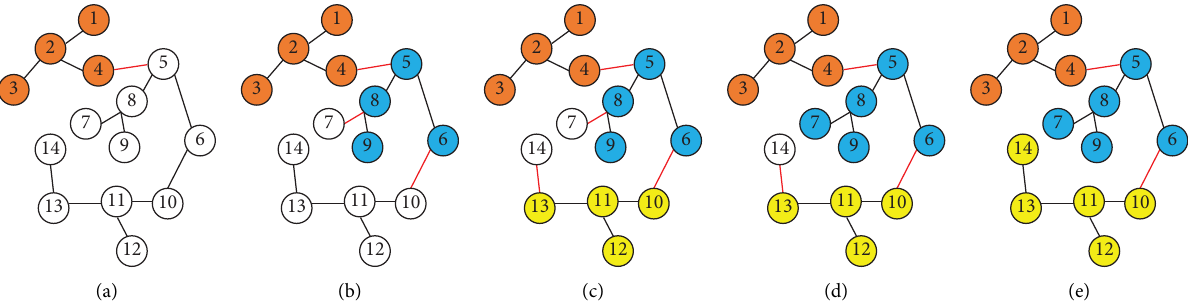
Figure 2: Te initial population generation procedure is explained from left to right. (a) Te edge (4, 2) gets chosen, and its end nodes (the nodes connected to both ends of the edge) get assigned to the corresponding community. Te edges of node 2 get processed, and the �� √ ��� |√ | n ⌉ � 􏼆 􏼇 � 4 ) , stops the expansion of the community, and chooses another edge; (b) procedure reaches the predefned threshold (⌈ 14 the edge (5, 8) gets chosen, and its end nodes get assigned to the community. Te broken edge between 5 and 4 gets ignored, but node 6 gets added to the community. Te (8, 9) edge gets processed, and, by adding node 9, the community’s size reaches the threshold value. Te rest of the edges in the queue get broken. (c) Te edge between 10 and 11 gets chosen, and the community gets expanded around the node 11. (d) Te edge between 7 and 8 gets chosen, and because it does not reach the threshold limit, the broken edge gets reconnected. (e) (13, 14) gets chosen, and the broken edge gets reconnected because the community members fail to reach the threshold